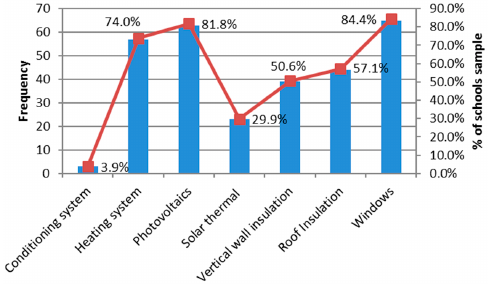
Figure 7. Frequency distribution of retrofit interventions.